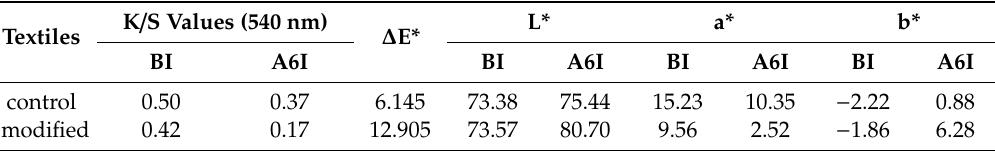
Table 3. Self-cleaning